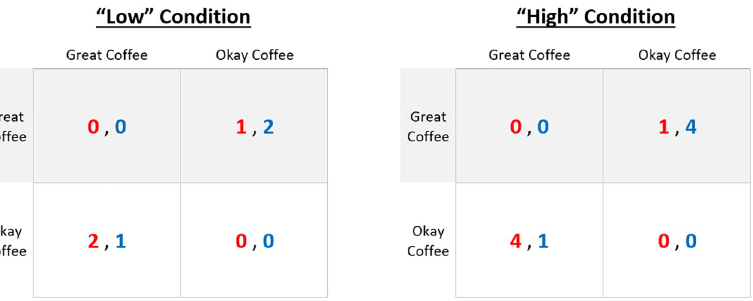
Fig 1. Payoff matrices of the original “Battle of the Exes” game. The numbers indicate the reward received by each player (red and blue). Reproduced from [23].